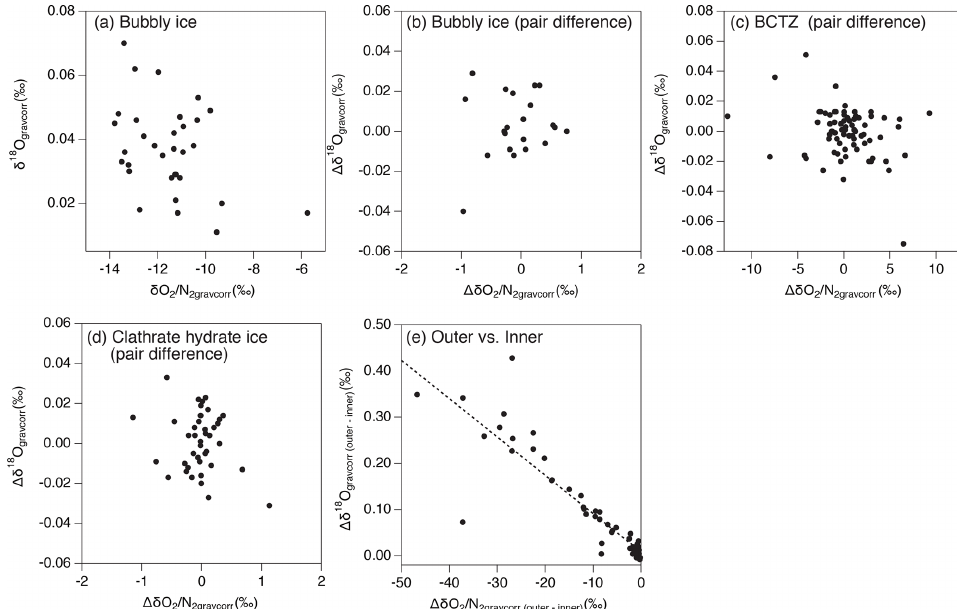
Figure B5. Relationship between δ O 2 / N 2gravcorr and δ 18 O gravcorr for (a) the last 2000 years for bubbly ice, (b) pair differences in bubbly ice zone, (c) pair differences in BCTZ, (d) pair differences in clathrate hydrate ice zone, and (e) differences between the outer ice and inner ice (bubbly ice and clathrate hydrate ice). The dashed line represents linear fit to the data ( (cid:49)δ 18 O gravcorr = − 0 . 0083 (cid:49)δ O 2 / N 2gravcorr + 0 .